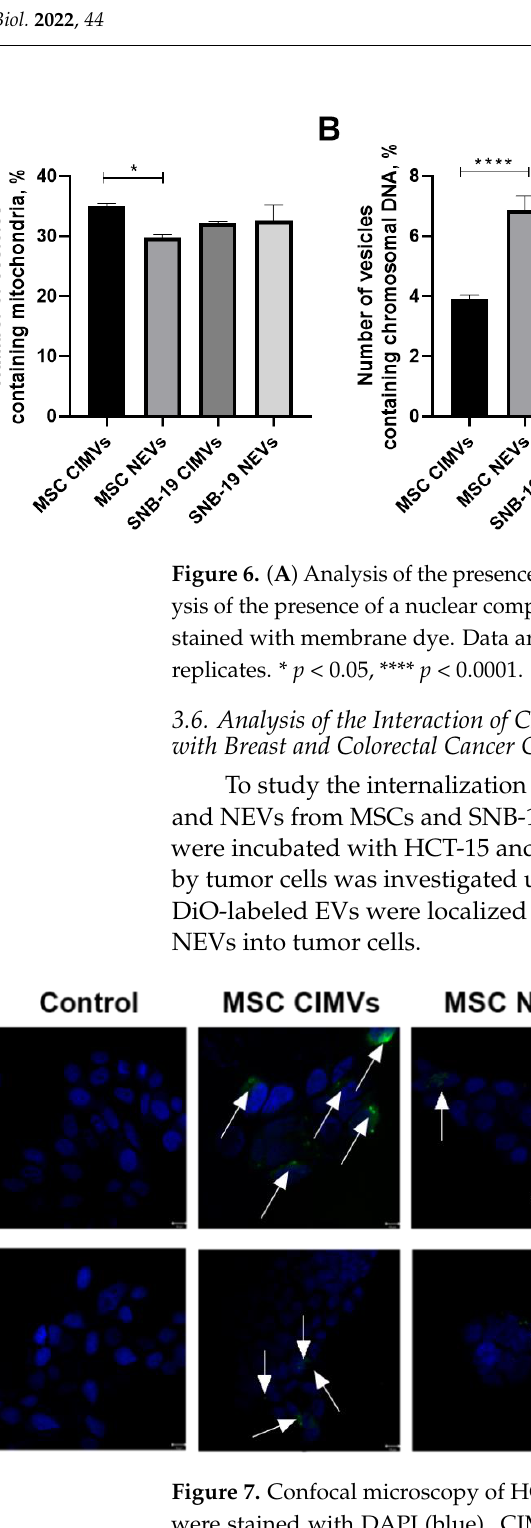
Figure 7. Confocal microscopy of HCT-15 and MCF7 tumor cells in monolayer culture. Cell nuclei were stained with DAPI (blue). CIMVs and NEVs stained with DiO membrane stain (green) are shown by arrows. Scale: 100 µm.